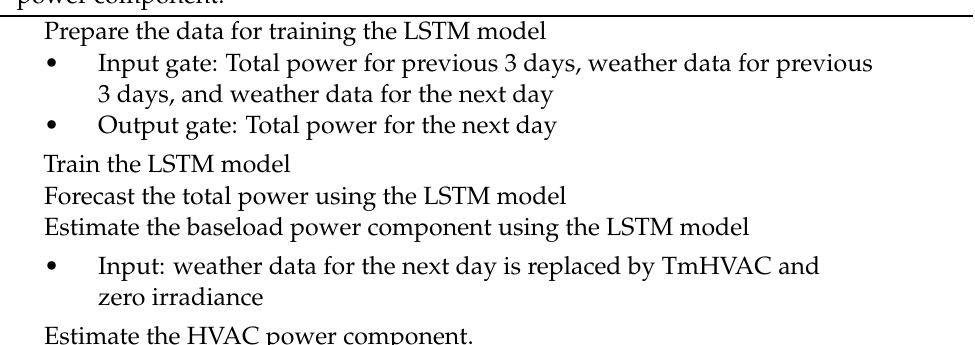
Algorithm 2: Total and baseload forecast and disaggregation of the HVAC power component.